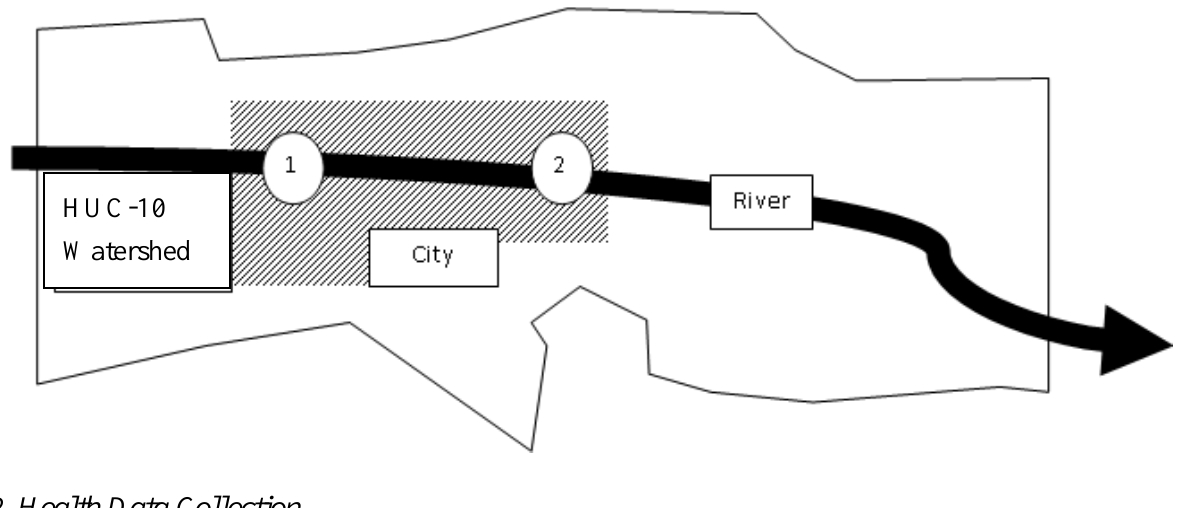
Figure 1. Sampling design illustrating regional elements: watershed, civil division (referred to as cities), stream/river, and sediment sampling sites (1 = Upstream, 2 =